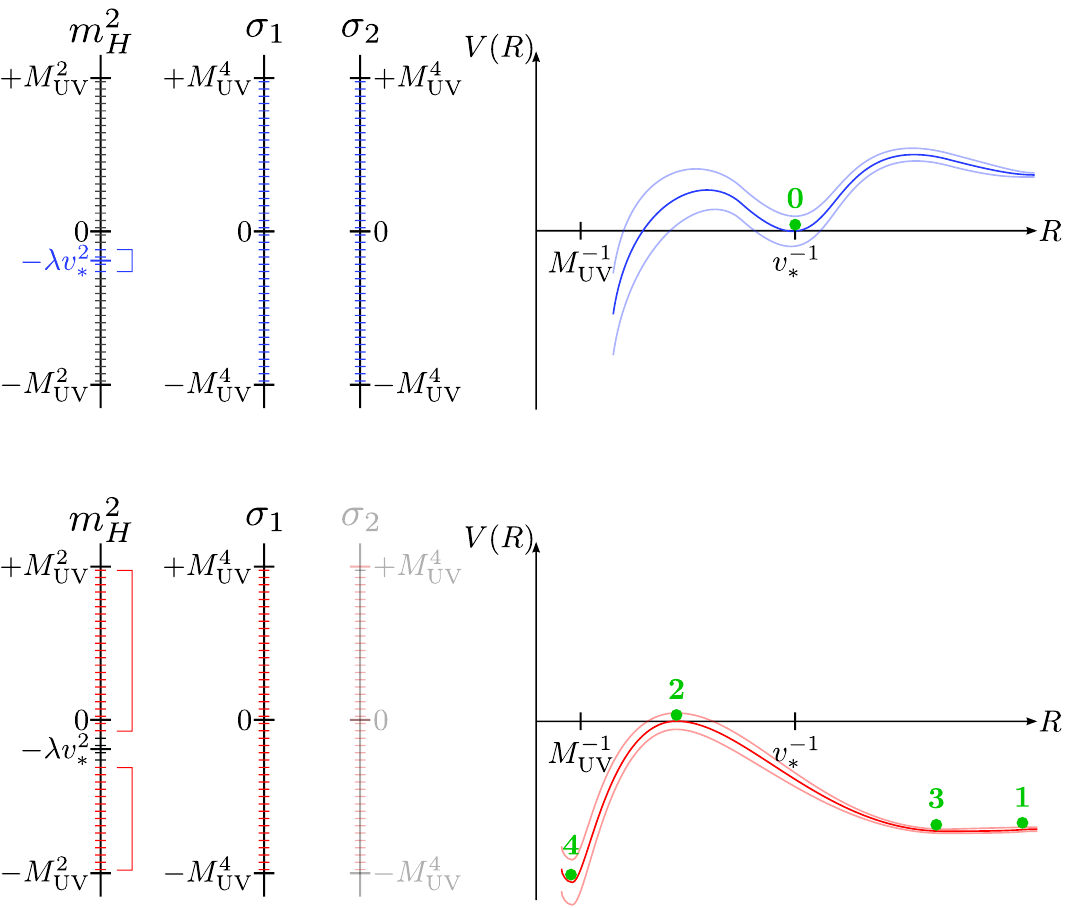
Figure 6 . Schematic of the classes of vacua. Class I vacua (top): for Higgs masses m 2 (cid:21)v 2 technically natural scale (indicated in blue), the Casimir stress generated by a bulk fermion (cid:3) (cid:0) is such that the e(cid:11)ective radion potential V ( R ) can be stabilized with near-zero 4D e(cid:11)ective cosmo- logical constant (cid:3) 4 , at a physical distance R near the inverse of the critical Higgs vev v (cid:3) . In such a radion minimum (Point 0 , green), both brane tensions (cid:27) 1 and (cid:27) 2 can assist in tuning the cosmo- logical constant. Class II vacua (bottom): for all other Higgs masses (indicated in red), the radion potential does not develop stable, static solutions; no con(cid:12)guration exists for which V ( R ) V 0 ( R ) = 0, and V 00 ( R ) > 0 for R & M (cid:0) 1 . Radion extrema are either a runaway direction such UV that the non-SM brane disappears from the e(cid:11)ective theory (Point 1), static but unstable (Point 2), or stable but nonstatic with large (cid:3) 4 (Point 3). The radion could be stabilized in the ultraviolet j j (Point 4), but with a much sparser distribution of vacua for the brane tensions. Di(cid:11)erent curves in the radion potential correspond to di(cid:11)erent values of (cid:27) 2 . In this arrangement, the vast majority of vacua with a small (cid:3) 4 are of Class I, with a Higgs vev near v (cid:3) and extra-dimensional radius near v (cid:0) 1 (Point 0), realizing the vacuum structure of (cid:12)gure 1. (cid:3)